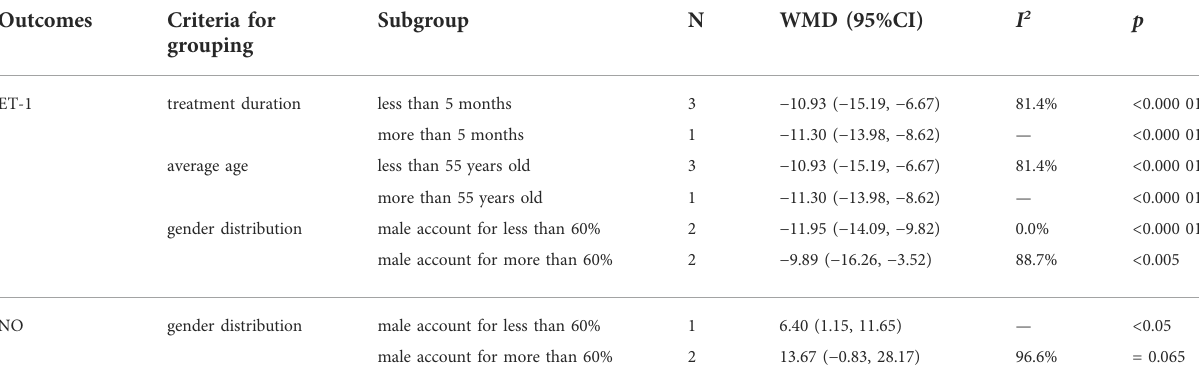
TABLE 3 Subgroup analysis of ET-1 and NO based on treatment duration, average age and gender distribution. Outcomes